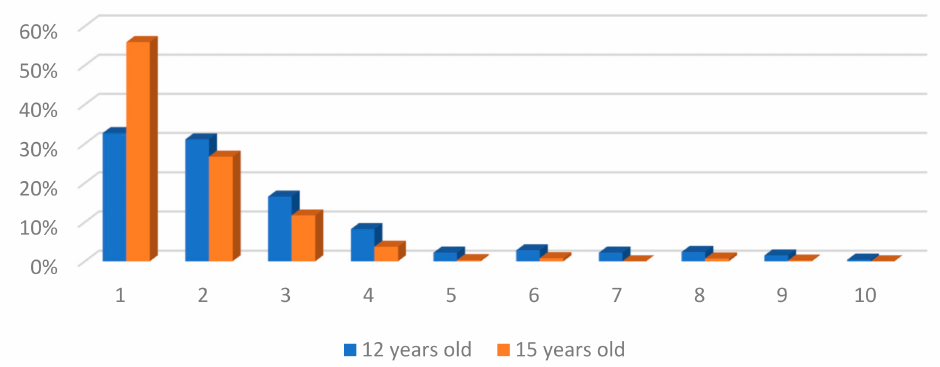
Figure 2. Distribution of the 10 grades of treatment need according to the aesthetic component of the IOTN